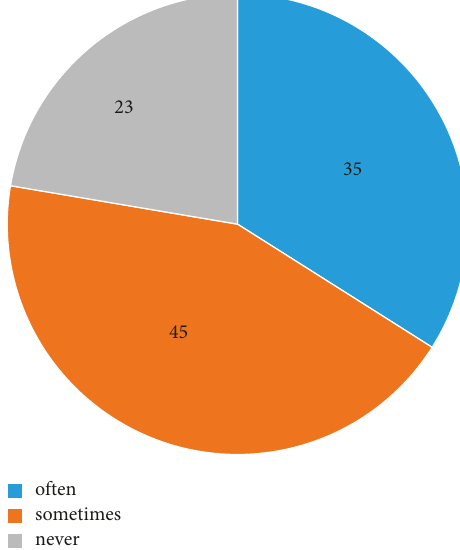
Figure 1: The phenomenon of cultural classes crowding out music classes in urban area.